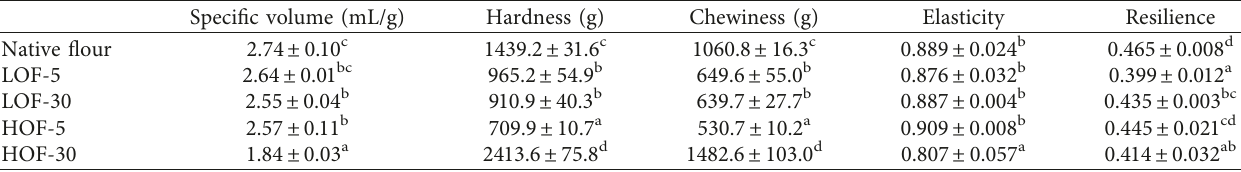
Table 2: The specific volumes and texture attributes of steamed breads made from native and ozone-treated wheat flours † . Specific volume (mL/g)